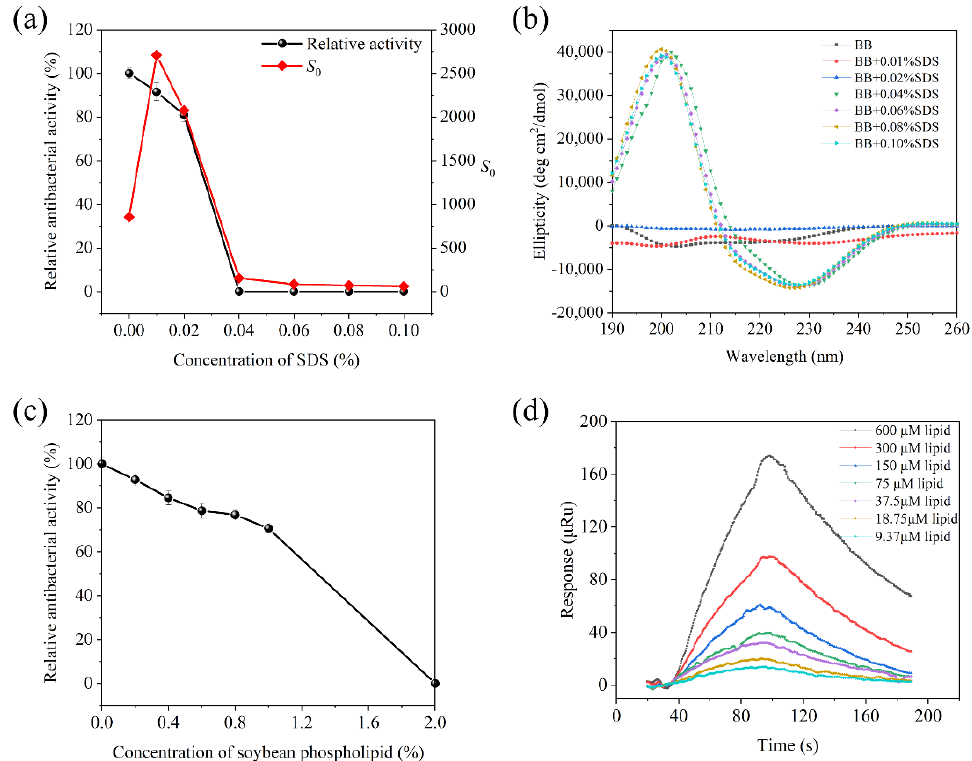
Figure 5. Effect of sodium dodecyl sulfate and soybean phospholipid on brevilaterin. ( a ) change of antibacterial activity and hydrophobicity S 0 affected by sodium dodecyl sulfate. Values are the mean ± SD from three trials; ( b ) circular dichroism spectrum changes of brevilaterin B in sodium dodecyl sulfate solution; ( c ) antimicrobial activity change of brevilaterin B in soybean phospholipid solution. Values are the mean ± SD from three trials; ( d ) binding interaction curve between brevilaterin B and soybean phospholipid determined by surface plasmon resonance technology.